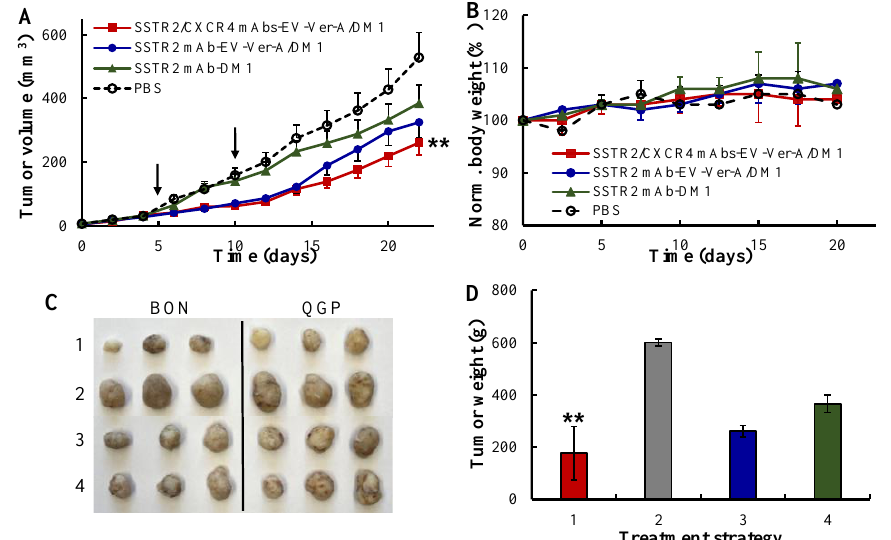
Figure 5. In vivo anticancer e ffi cacy of dual-targeted Ver-A / DM1 in NET (BON-Luc and QGP) xenografted mouse model. ( A ) Tumor volume changes in NET xenografts followed the treatment (data represent mean ± SEM, n = 6). 3 × 10 6 mycoplasma-free BON-Luc or QGP cells were subcutaneously injected into nude mice. PBS ( ), single-targeted anti-SSTR2 mAb-EV-DM1 ( (cid:78) ), single-targeted anti-SSTR2 mAb-EV-Ver-A / DM1 ( • ), and dual-targeted anti-SSTR2 / CXCR4 mAbs-EV-Ver-A / DM1 ( (cid:4) ) on days 5 and 10. Tumor volume was measured with calipers, and calculated as ellipsoid. ** p < 0.005 vs. PBS using ANOVA followed by Dunnett’s t -test. Black arrow indicating the injection date of the targeting delivered Ver-A / DM1 or DM1 (1.24 mg / kg). ( B ) The normalized body weight. ( C ) Representative tumors harvested. ( D ) The total wet weight of the harvested NET (BON and QGP) xenograft tumors. ** p < 0.005 vs. PBS using ANOVA followed by Dunnett’s t